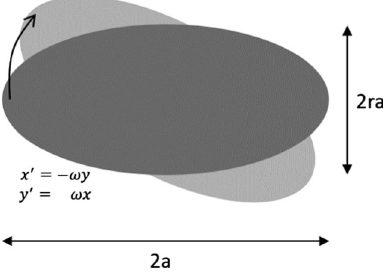
FIG. 8. Ellipse performing rigid and concentric